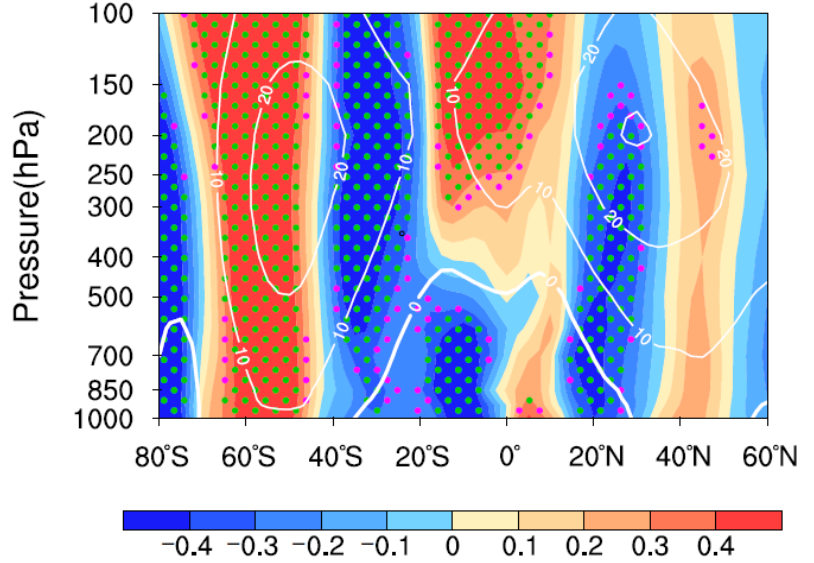
Figure 5. Partial correlation map between the winter SPODI and winter zonal wind averaged over 200 ◦ E–260 ◦ E without the ENSO signal. The magenta and green stippled areas indicate statistical significance at the 90% and 95% confidence levels, respectively. The white contours represent the climatological mean zonal wind in winter.